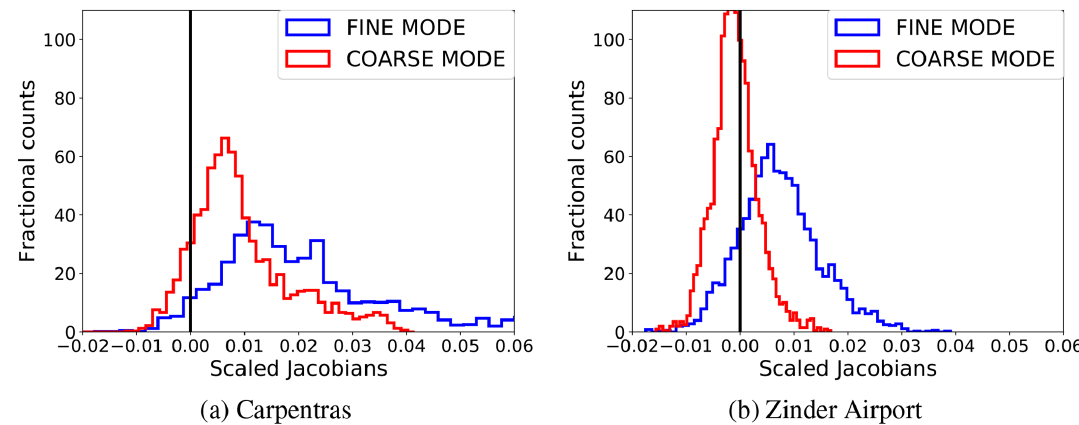
Figure 6. Distribution of the AOT-scaled Jacobian over Carpentras (dark surface) and Zinder Airport (bright surface). The histograms are obtained from PROBA-V observations (RED band) over the year 2015.